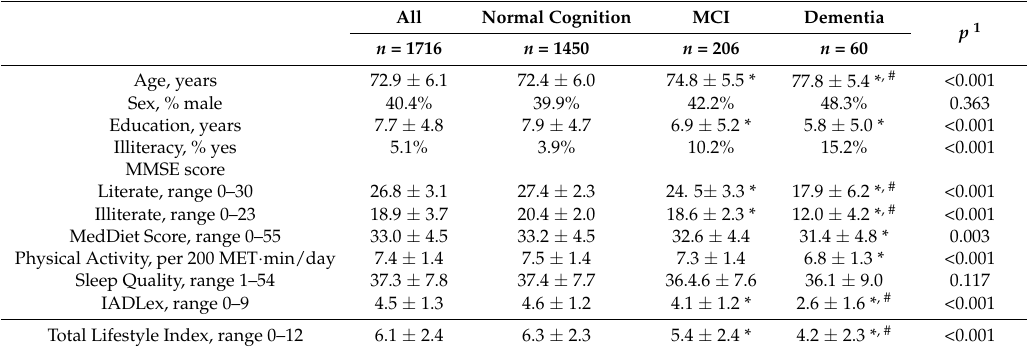
Table 1. Socio-demographic characteristics and lifestyle factors of the total sample and by diagnosis. All